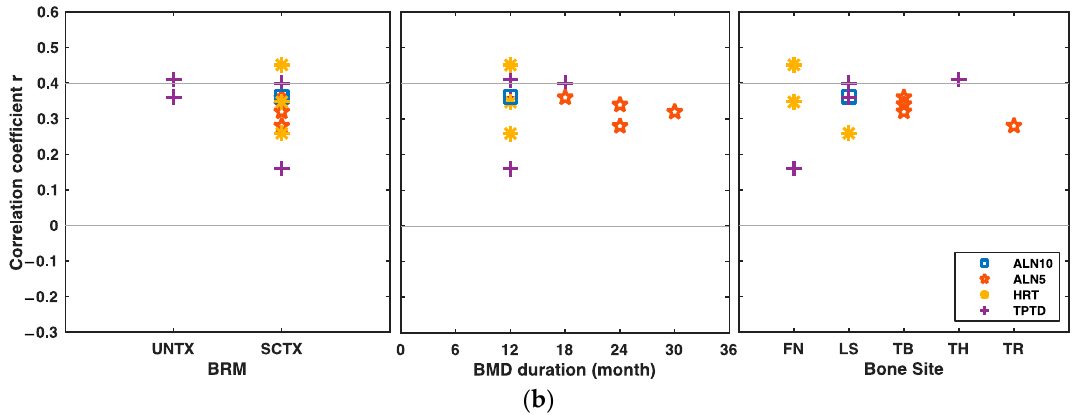
Figure 3. Significant correlations between baseline bone turnover markers (BTMs) and bone mineral density (BMD) changes at different bone sites under different drug interventions over time. ( a ) Correlations between baseline BFMs and BMD changes from baseline at different bone sites under different drug interventions over time. ( b ) Correlations between baseline BRMs and BMD changes from baseline under different drug interventions over time. BFM bone formation marker, BRM bone resorption marker, ALN alendronate, ALN5 5 mg/d ALN, ALN10 10 mg/d ALN, ALN10+HRT, combination of 10 mg/d ALN and HRT, HRT hormone replacement therapy, TPTD teriparatide, FN femoral neck, LS lumbar spine, TB total body, TH total hip, TR trochanter.